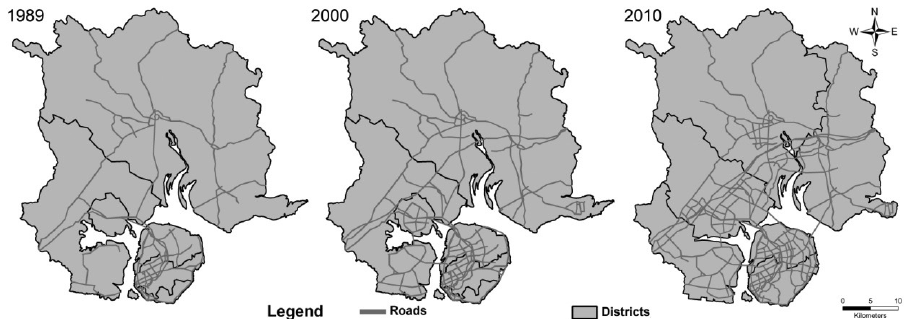
Figure 5. Road expansion from1989 to 2010 (figure drawn by the author)